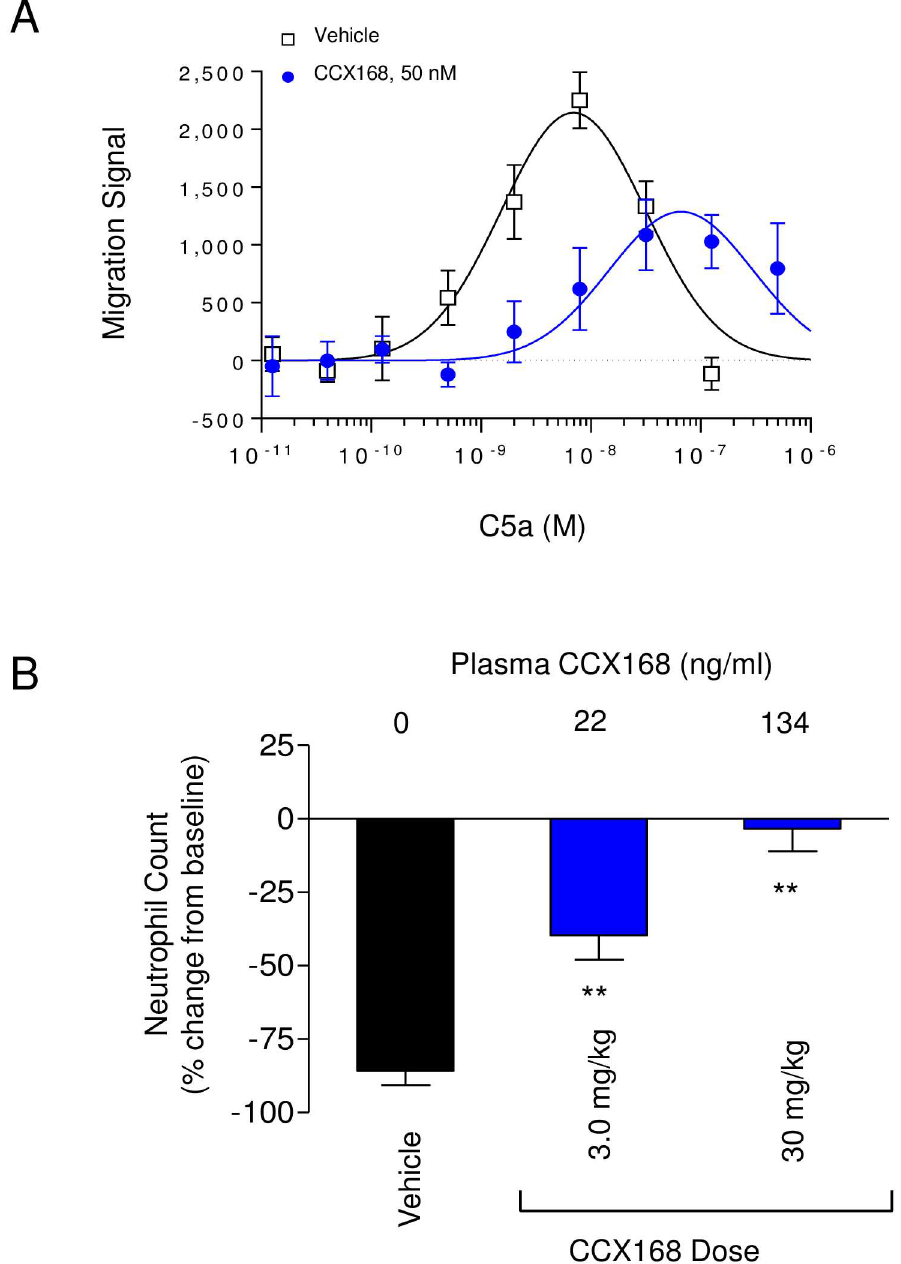
Fig 6. Biological Effects of CCX168 in Cynomolgus Monkeys. (A) In vitro C5a-induced chemotaxis of freshly-isolated neutrophils from cynomolgus monkeys, conducted in 100% cynomolgus plasma containing vehicle ( □ ) or 50 nM CCX168 ( ● ). CCX168 inhibitedneutrophilchemotaxis (A 2 = 3.0 nM). Each data point represents the mean of 8 replicates ± standard error, and the study was repeated 2 separate times. (B) In vivo effect of CCX168 in the C5a-induced neutropenia model in monkeys. The percent changein the number of neutrophils in the blood collected after C5a injection, relative to the sample collectedprior to C5a injection, is shown (4 monkeys per group). Above each bar is the average concentration of CCX168 in the pre-injection blood samples. CCX168 inhibited,in a dose-dependent manner, the depletionof blood neutrophils caused by intravenous administration of C5a. ** p < 0.01based on Student’s